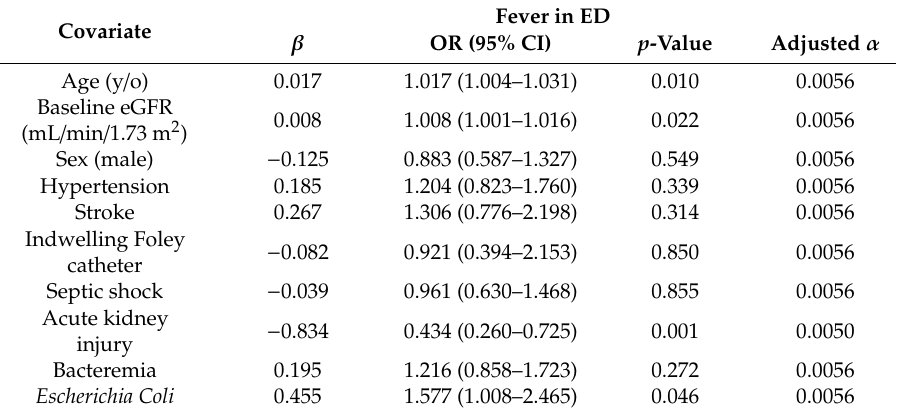
Table 7. Multivariate logistic regression model for factors related to fever during the stay in emergency department among patients with subsequent febrile urinary tract